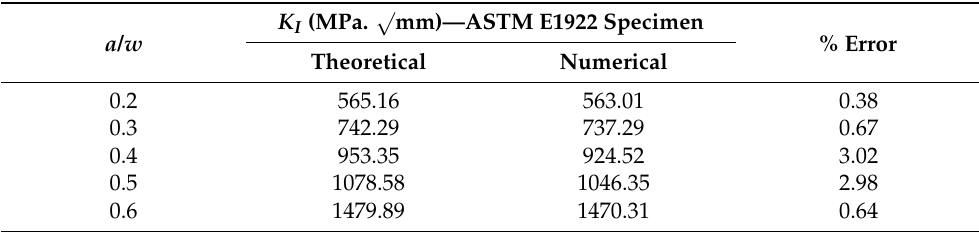
Figure 14. Comparison between the theoretical and numerical results of SIF for TTC ASTM E1922 specimen. Table 7. Comparison between the theoretical and numerical results of SIF and Y.